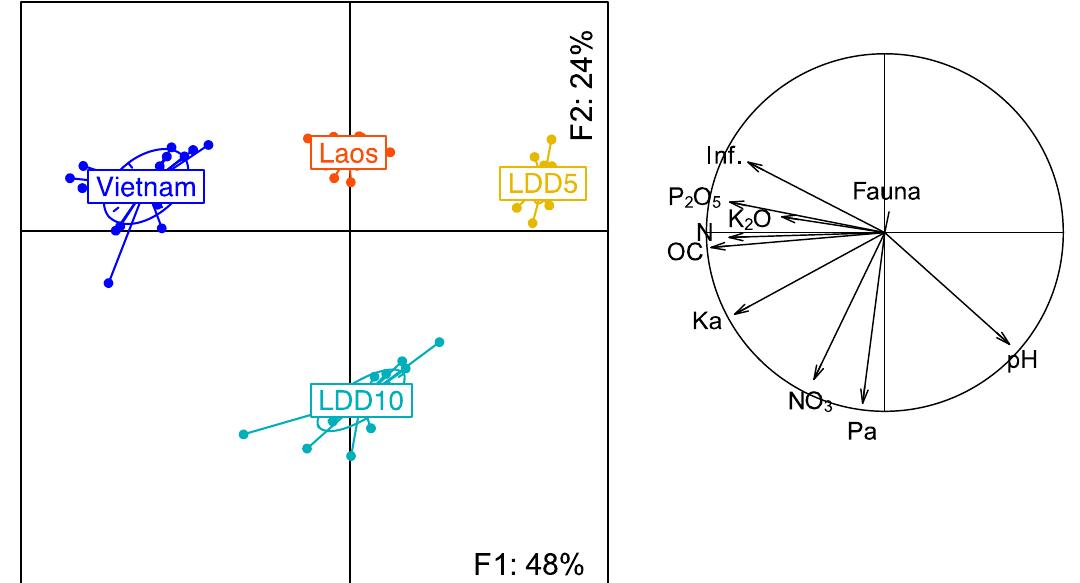
Figure 1. Biplot showing of the principal component analysis (PCA) performed on soil properties. Variables are: pH H2O , OC, N, NO 3 − N, total K and P (P 2 O 5 , K 2 O), available K and P (Pa and Ka), abundance of earthworm, ants and termites (fauna) and infiltration rate (inf).